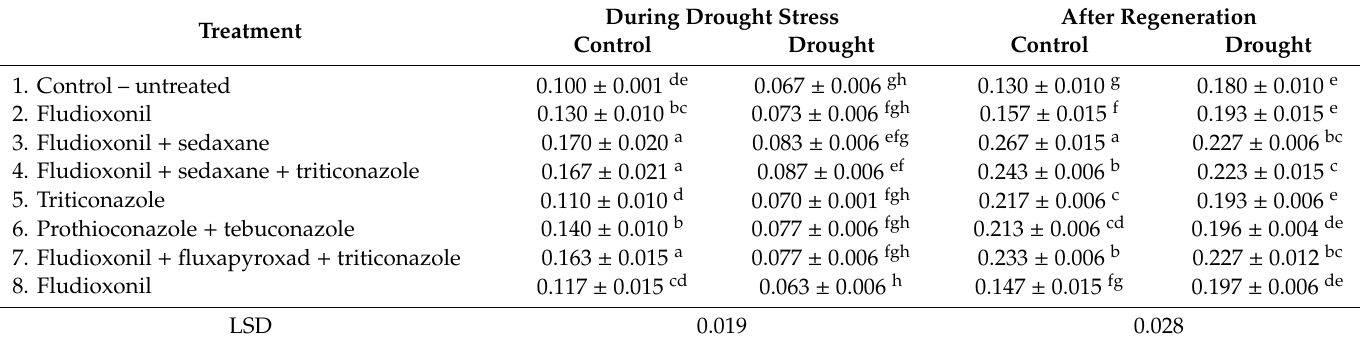
Table 5. The influence of the seed treatment and drought stress on stomatal conductance – Gs (mol × m − 2 × s − 1 ) during drought stress and after regeneration.